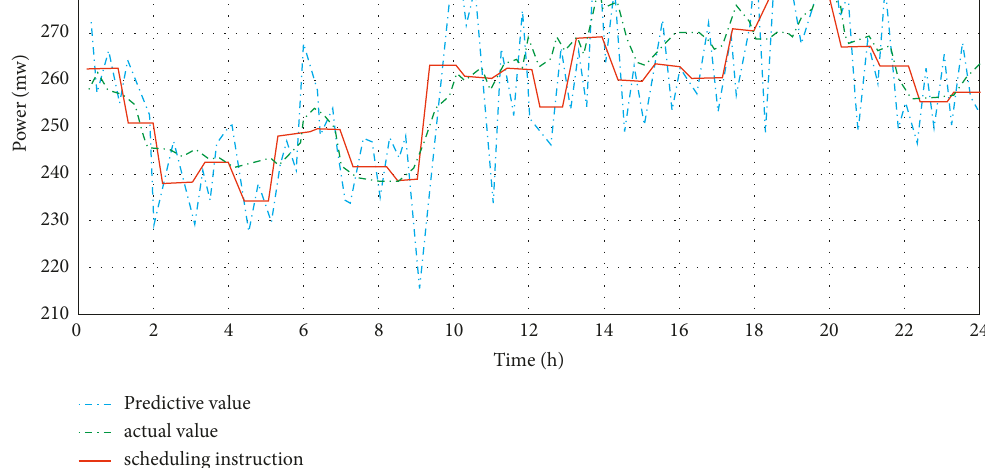
Figure 3: Schedule instruction curve.